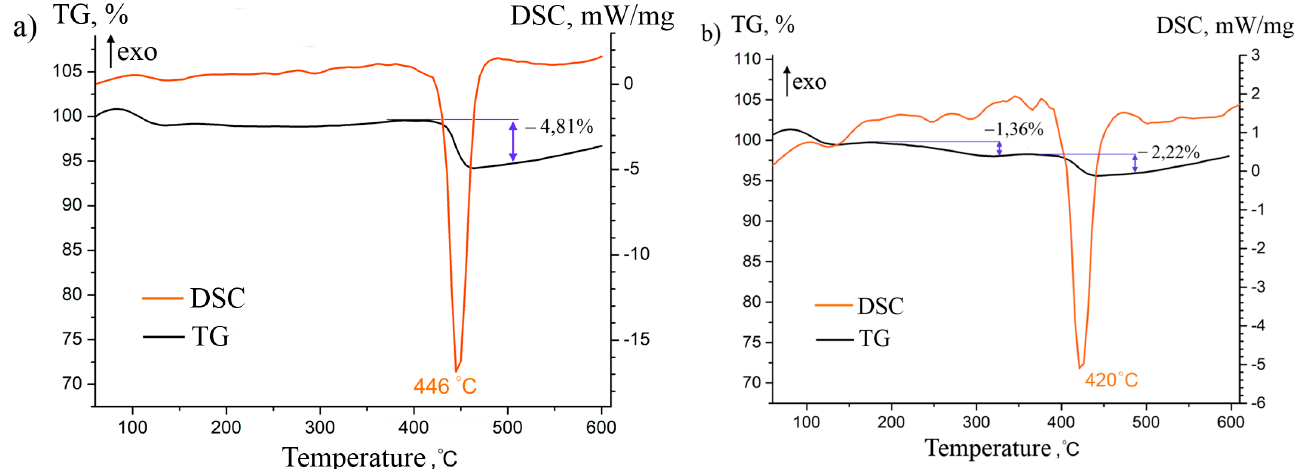
Figure 8. Results of TG and DSC analysis for magnesium hydride ( a ) and MgH 2 –5 wt.% SWCNT composite ( b ) obtained at a speed of 300 rpm.